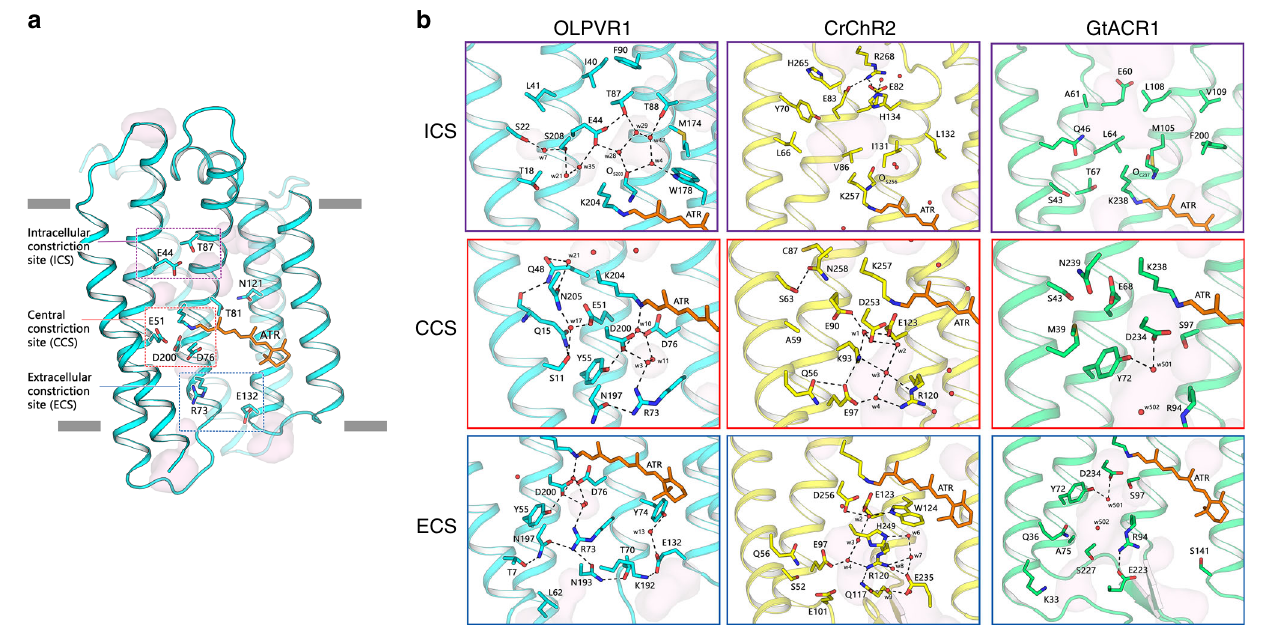
Fig. 5 Organization of ion pathway constriction sites (CSs) in OLPVR1. a Three CSs and cavities are forming the putative ion-conductive pathway in viral CCRs and highly conservative residues of OLPVR1. TM6 and TM7 helices are omitted for clarity. Membrane core boundaries were calculated using PPM server 103 and are shown with gray lines. b Magni fi ed view of the CSs in OLPVR1 (left, present work), Cr ChR2 (middle, PDB ID: 6EID 8 ) and (right, PDB ID: 6CSM 10 ) structures, colored cyan, yellow and green, respectively. Water accessible cavities were calculated using HOLLOW 105 and are presented as a pink